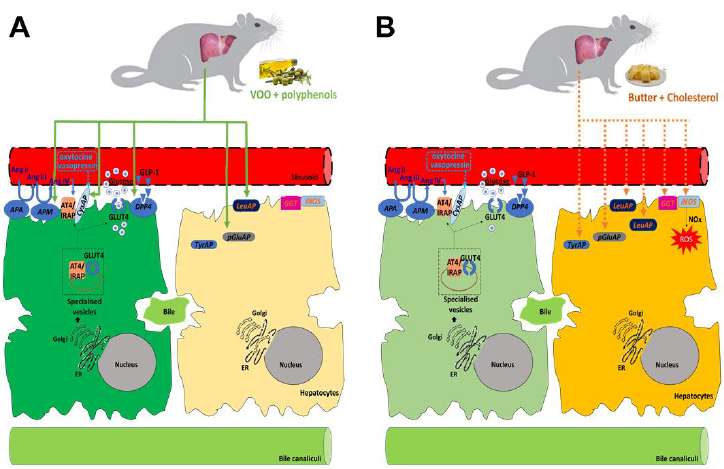
Figure 6. Schematic diagram modeling the role of the high-fat diets (HFDs) that are associated with changes